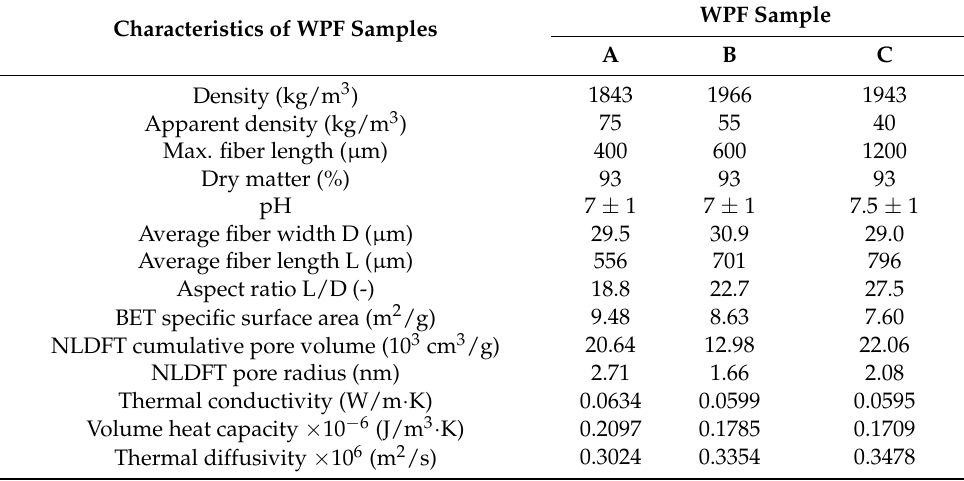
Table 4. Physical properties of WPF